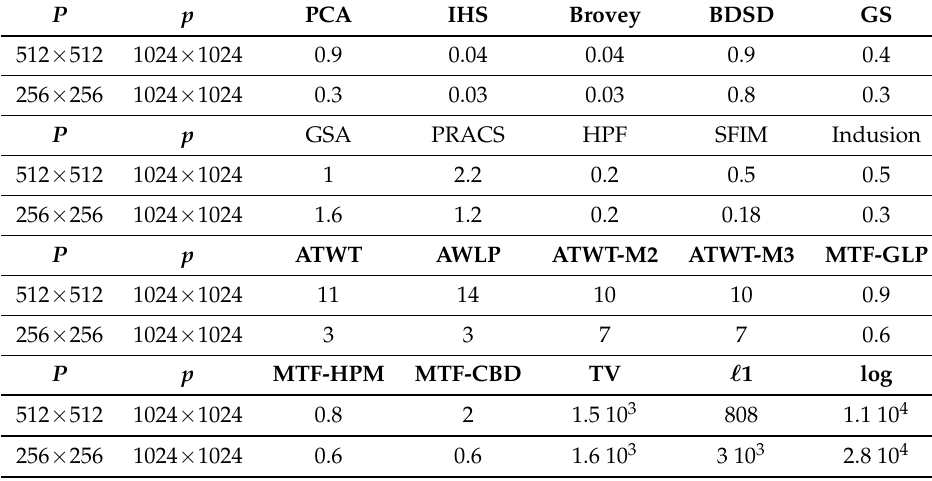
Table 13. Elapsed CPU time in seconds for the different pansharpening methods on a 1024 × 1024 image and with different p / P